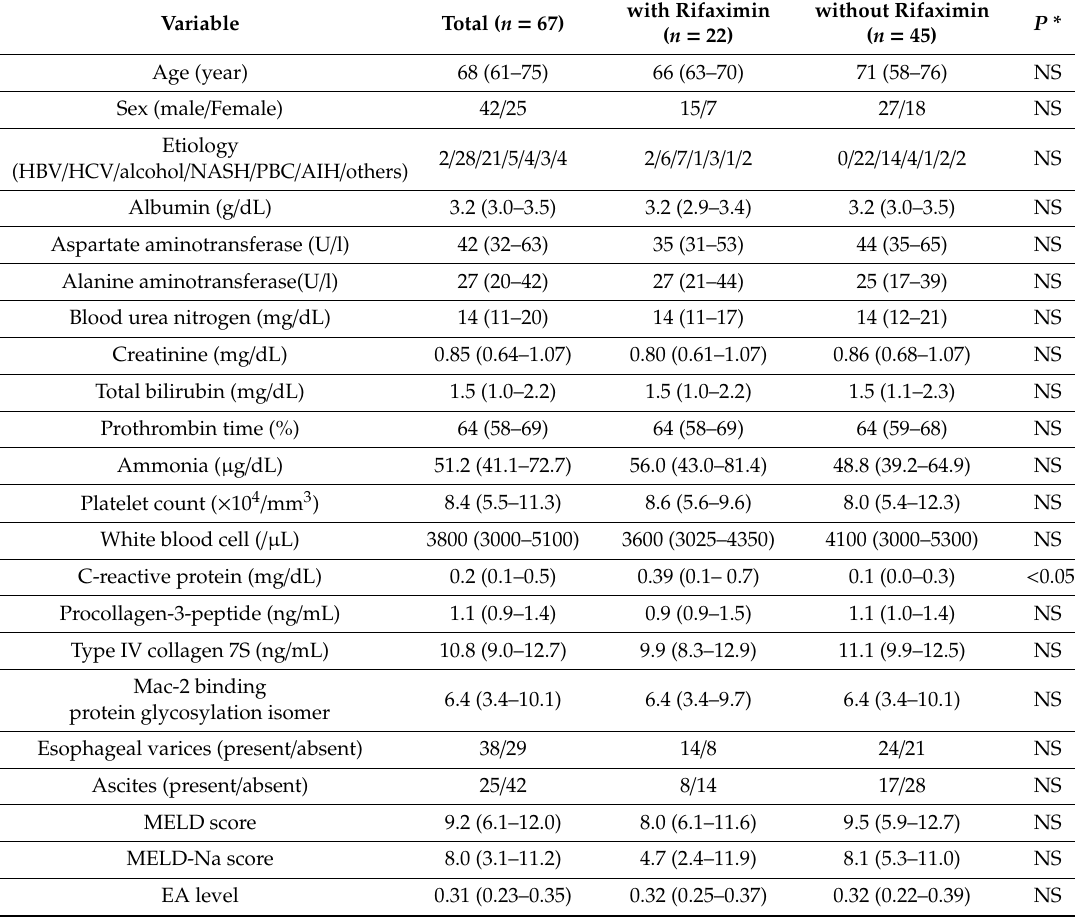
Table 4. Characteristics of Child B class patients before rifaximin